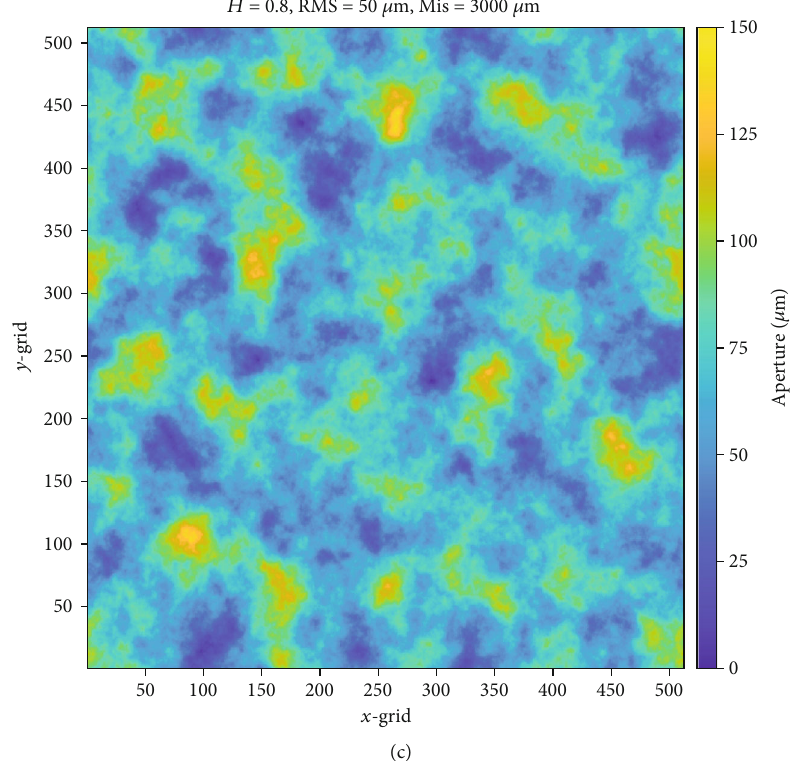
Figure 14: E ff ect of the λ value on the aperture fi eld. RMS = 50 μ m and H = 0 : 8 . The scale of the color bar is between 0 and 150 μ m. The c = 1000 μ m , which corresponds to surface pair 2 in Table 2; (b) number of grids in the x and y directions is 512. (a) Aperture fi eld when λ c = 2000 μ m , which corresponds to surface pair 4 in Table 2; (c) aperture fi eld when λ aperture fi eld when λ c value is increased from (a) to corresponds to surface pair 5 in Table 2. The λ c